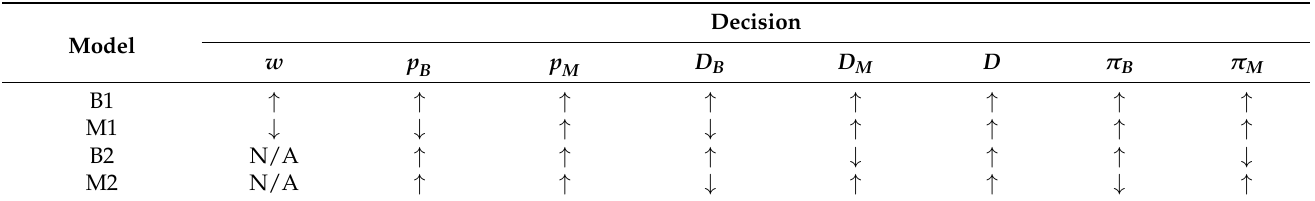
Table 1. The influence of the unit subsidy s on equilibrium decisions under four models.